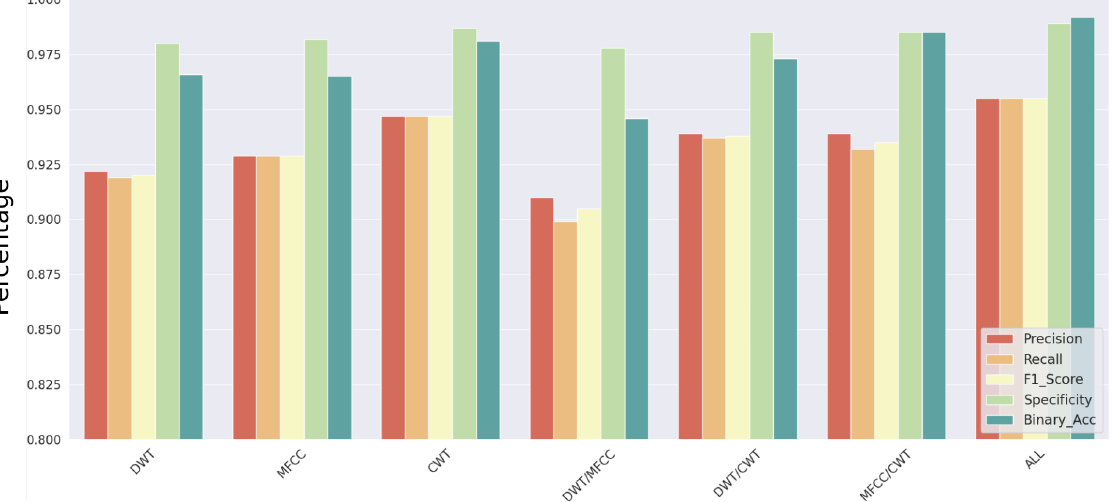
Figure 7. Performance of c4 the complete model for different percentages of training data split. Boxplot of F1 score of a ten folds test, green dotted line shows the increase of the median adjusted to a cuadratic function. The black dotted line shows the tendency of the best model for each percentage tranfered to classify binary classes and, the red triangles accounts for the performance reached with a 100% of the data set as training set.